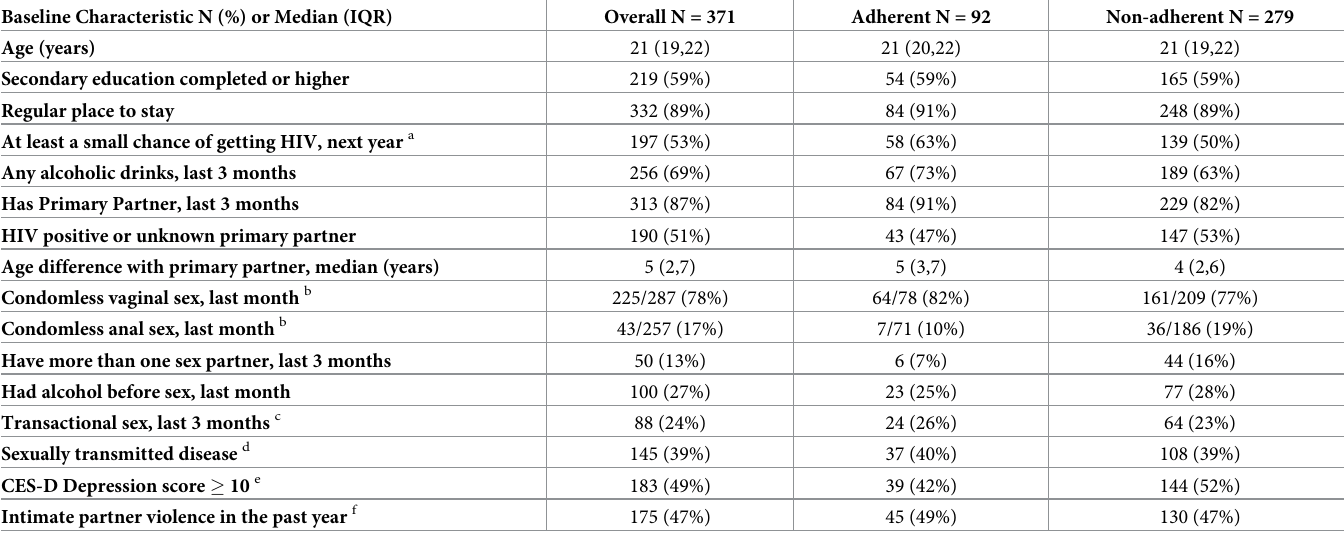
Table 2. Baseline characteristics of the participants by month three